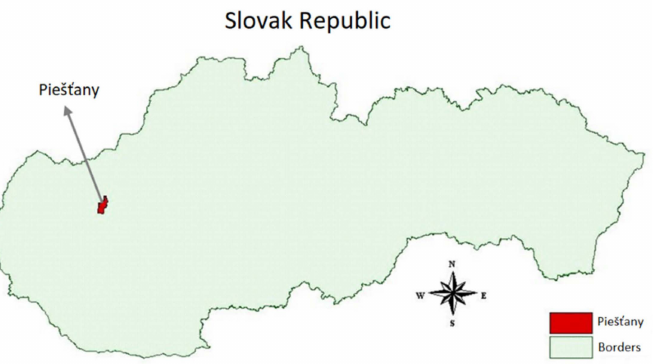
Figure 1. Map of the Slovak Republic with the town Piešt’any, which is the location of the Research Institute of Plant Production.